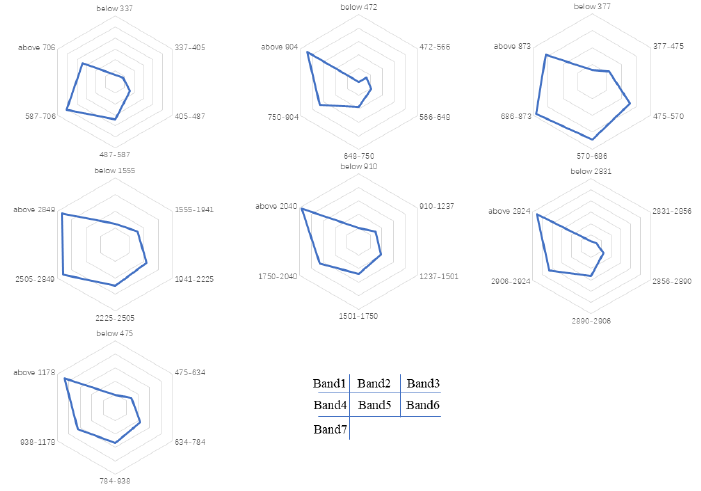
Figure11. Relativedistributionofdi ff erentinfluencingfactorsandpost-earthquakelandslideoccurrence Figure 11. Relative distribution of different influencing factors and post ‐ earthquake landslide with pre-earthquake Landsat TM occurrence with pre ‐ earthquake Landsat TM data.